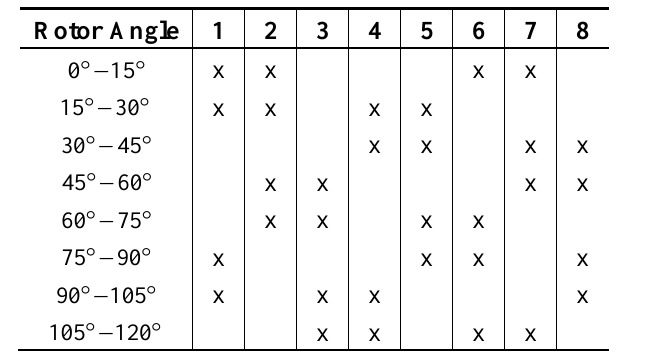
Figure 4. An example of the phase configuration and pole numbering in an 8/3 AFSRM, prior to optimization. Table 1. Stator pole activation strategy in an 8/3